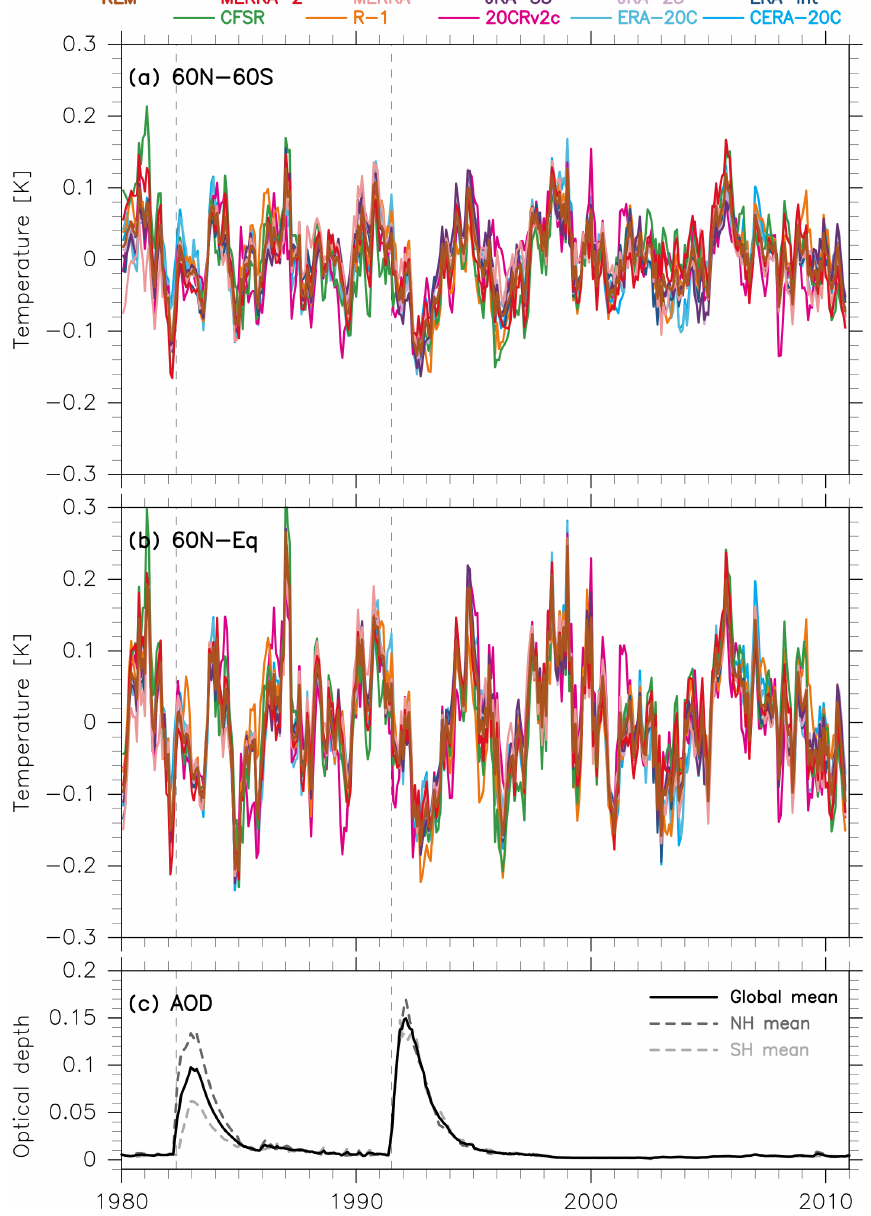
Figure 1. (a) Time series of the temperature residual R(t) (including volcanic signals and random variations) averaged for (a) 60 ◦ N–60 ◦ S and (b) 60 ◦ N–Equator as obtained from the 1980–2010 MLR analysis for 10 reanalysis data sets as well as the reanalysis ensemble mean (REM) (see legend at top). Three-month running means have been applied to each time series. (c) Time series of aerosol optical depth at 550nm in the stratosphere (Sato et al., 1993; obtained from https://data.giss.nasa.gov/modelforce/strataer/ (last access: 25 July 2018); black solid for the global mean, dashed darker grey for the NH mean, and dashed lighter grey for the SH mean). For all panels, vertical dashed lines indicate the start dates of the two volcanic